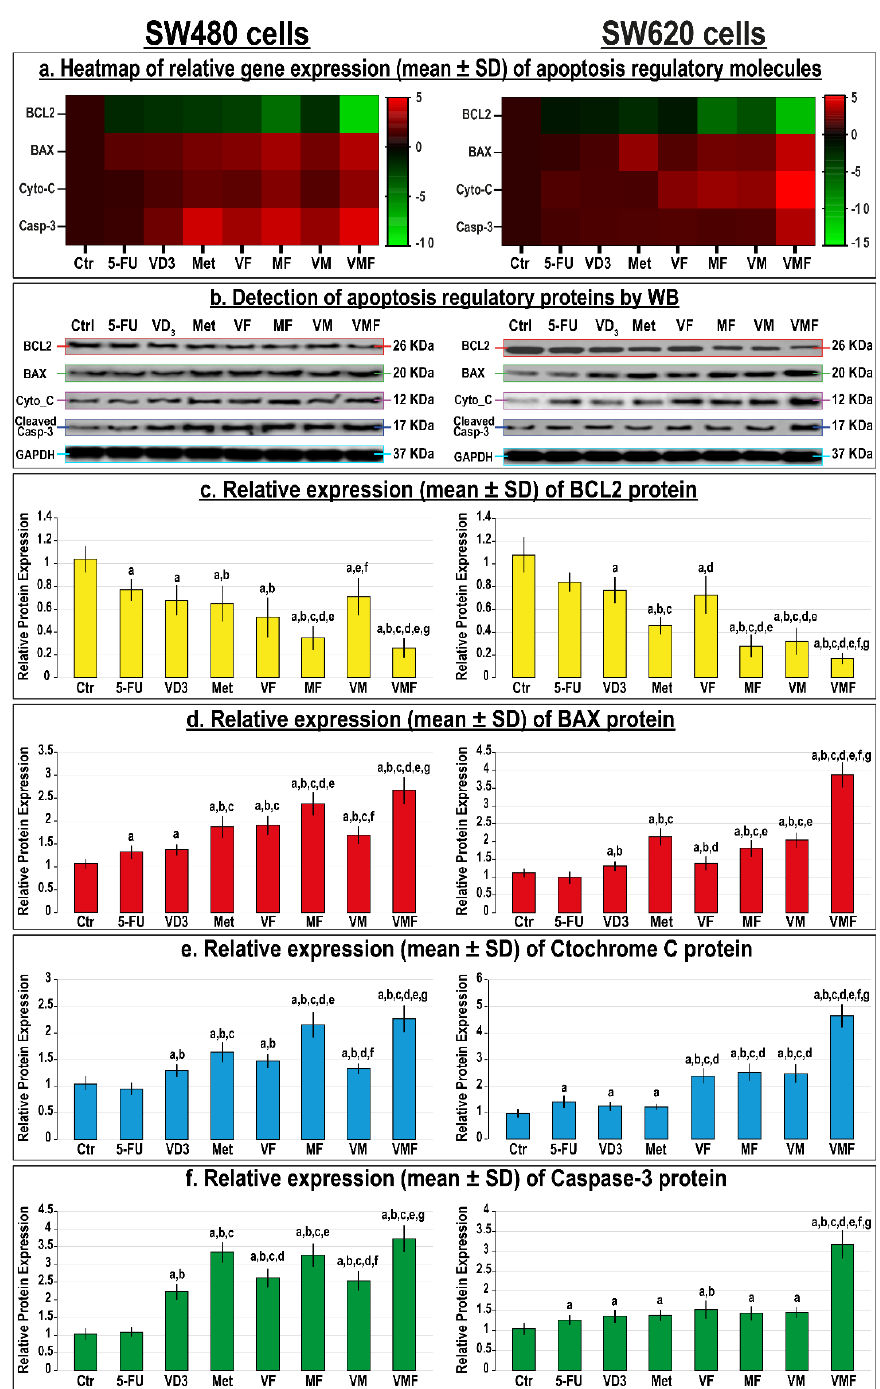
Figure 7. ( a ) Heatmap showing relative mRNA expression (mean ± SD) of BCL2, BAX, cytochrome C, and caspase-3 genes alongside ( b ) detection of their proteins by Western blot and ( c – f ) their relative protein expression (mean ± SD) following treatments with 5-fluorouracil, calcitriol, and/or metformin single (5-FU, VD 3 , and Met), dual (VF, MF, and VM), and triple (VMF) therapies for 12 h in the SW480 and SW620 colon cancer cell lines (n = 3/group; data were analysed by ANOVA followed by Games–Howell post hoc tests and are shown as the mean ± SD; a = p < 0.05 compared with control untreated cells; b = p < 0.05 compared with 5-FU monotherapy; c = p < 0.05 compared VD 3 monotherapy; d = p < 0.05 compared with Met monotherapy; e = p < 0.05 compared with VF dual therapy; f = p < 0.05 compared with MF dual therapy; and g = p < 0.05 compared with VM dual